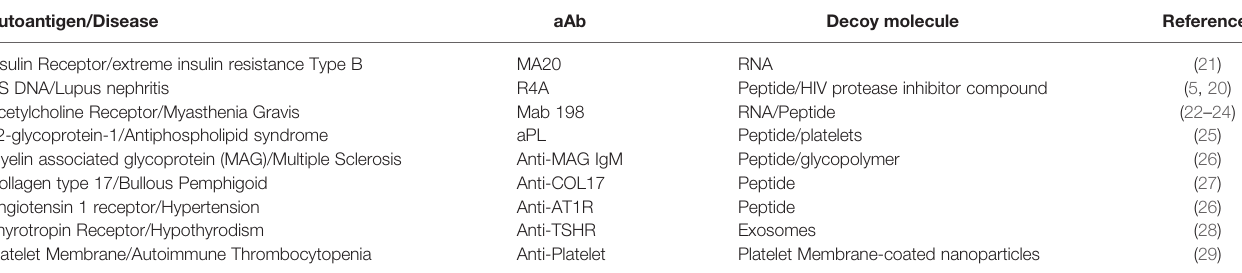
TABLE 2 | Reported Synthetic Autoantibody Decoys/Autoantigen Mimics.